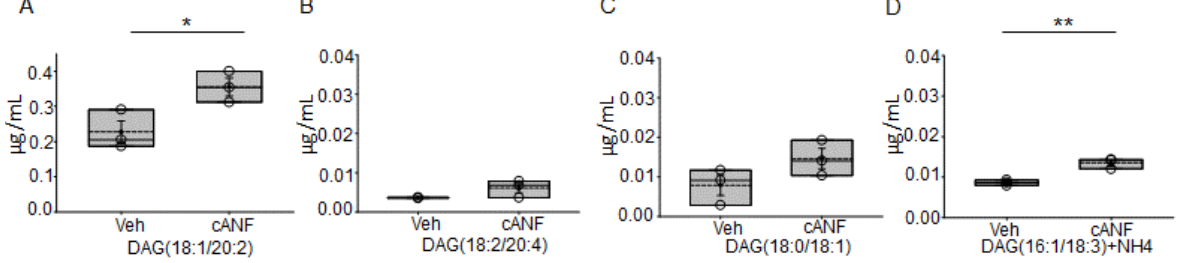
Figure 4. Quantification of diacylglycerols in hAoECs treated with cANF or vehicle. ( A ). DAG(18:1/20:2), ( B ). DAG(18:2/20:4), ( C ). DAG(18:0/18:1), ( D ). DAG(16:1/18:3) were among some diacylglycerols quantified in hAoECs treated with vehicle (Veh) or cANF for 8 h. A Student’s t -test was performed to make comparisons between the two groups. n = 3 samples in the vehicle and cANF groups. * represents a p -value < 0.05. ** represents a p -value < 0.01.